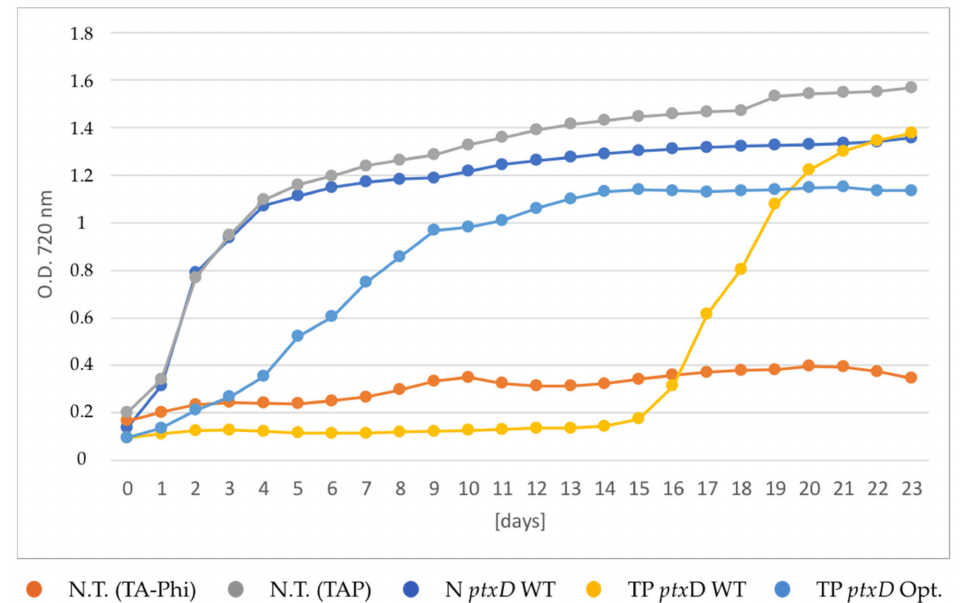
Figure 4. Growth curves of transgenic lines expressing the ptxD transgene in di ff erent cellular compartments. The selective growth phenotype was assessed by cultivating the algae in TA-Phi medium, following a phosphate-depletion treatment. The untransformed T222 wild type was cultivated in both TA-Phi (red trace) and TAP (grey trace) media as negative and positive controls, respectively. The nuclear transformant N ptxD WT (dark blue trace) and two independent transplastomic lines carrying the two PTXD versions (TP ptxD WT, yellow trace and TP ptxD Opt, light blue trace, respectively) were included in the experiment. Traces refer to the average of two technical replicates of growths performed in parallel. Cell density was measured by recording optical density at 720